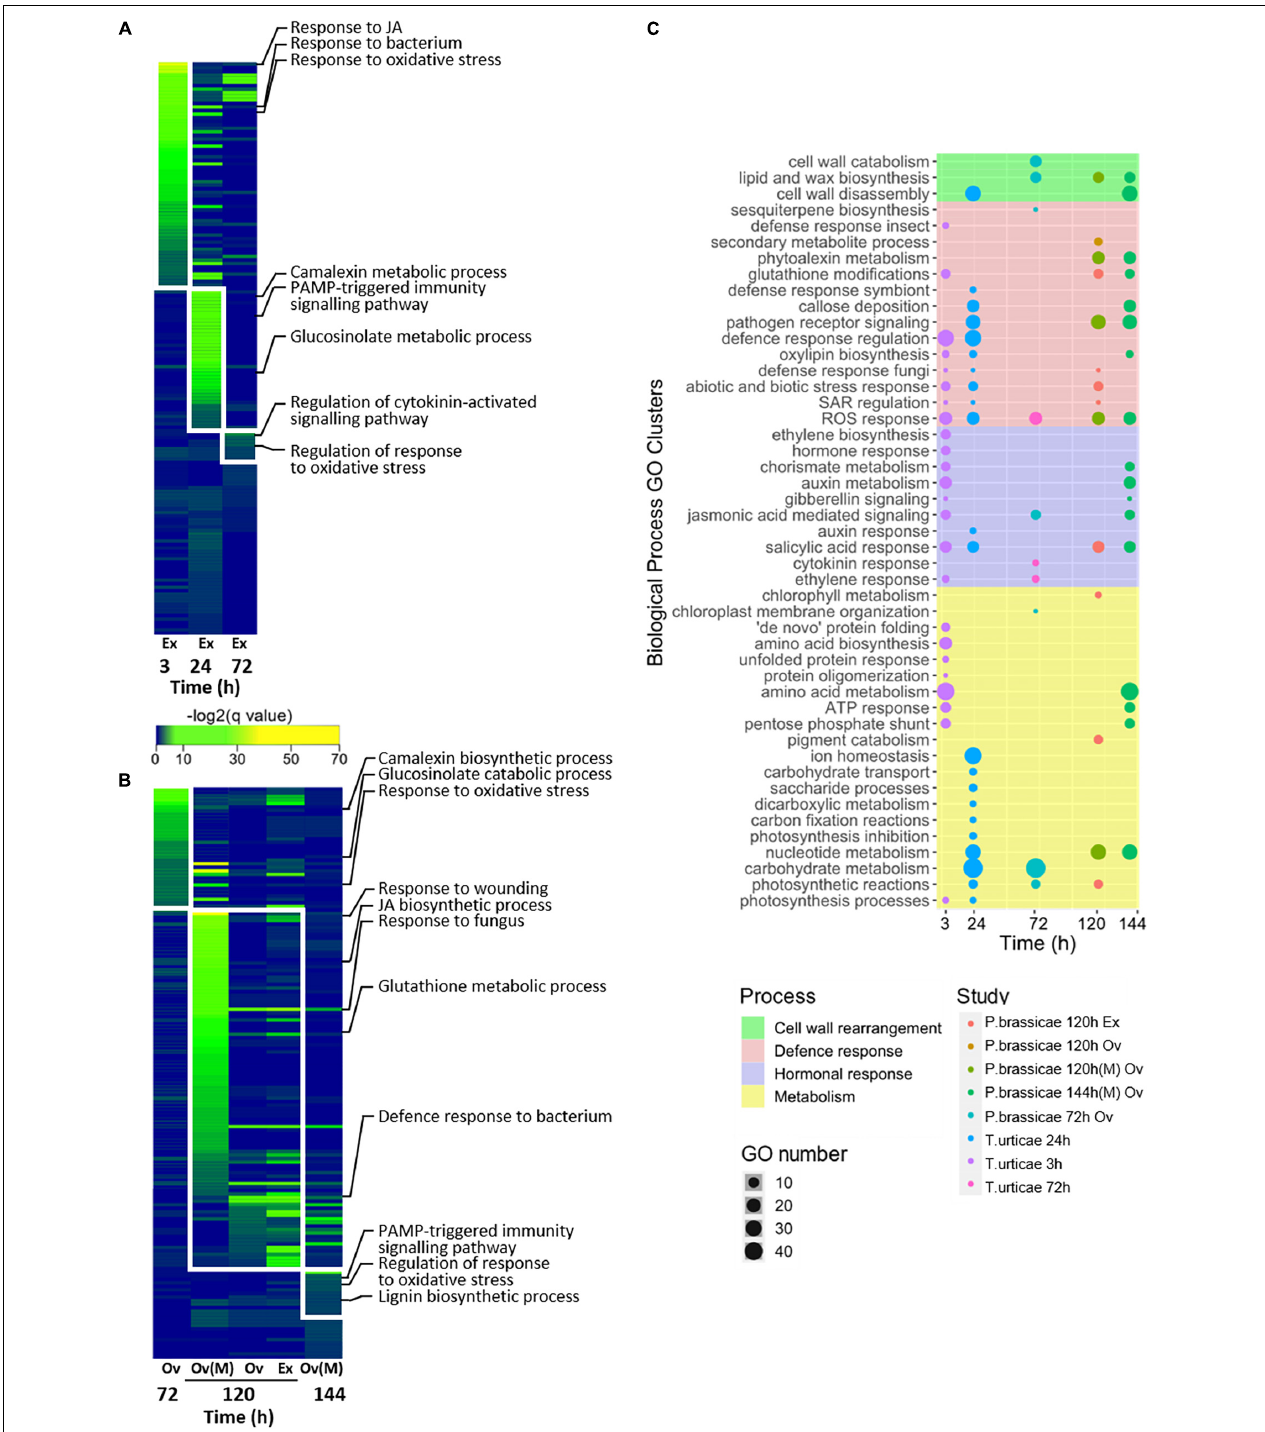
FIGURE 3 | Identification and clusterization of the main BPs across experiments. (A) Waves of time-specific BPs identified for T. urticae . (B) Waves of time-specific BPs identified for P. brassicae . (C) Clusterization of the similar biological processes (BPs) at each time point. The names of the clusters are shown and the major processes to which they belong are represented as different colors. Species and time (h) are stated for each study; stresses are identified as Ov (oviposition) and Ex (egg extract). All T. urticae data were obtained from egg extract stress. To represent (A,B) , a log transformation of the corrected p -values of the BP enrichments was used. Microarray results are identified by an (M), the rest of the results were obtained from RNA-seq data. Enrichment was calculated using an over representation analysis (ORA) test with Benjamini–Hochberg correction [false discovery rate (FDR) ≤ 0.05].